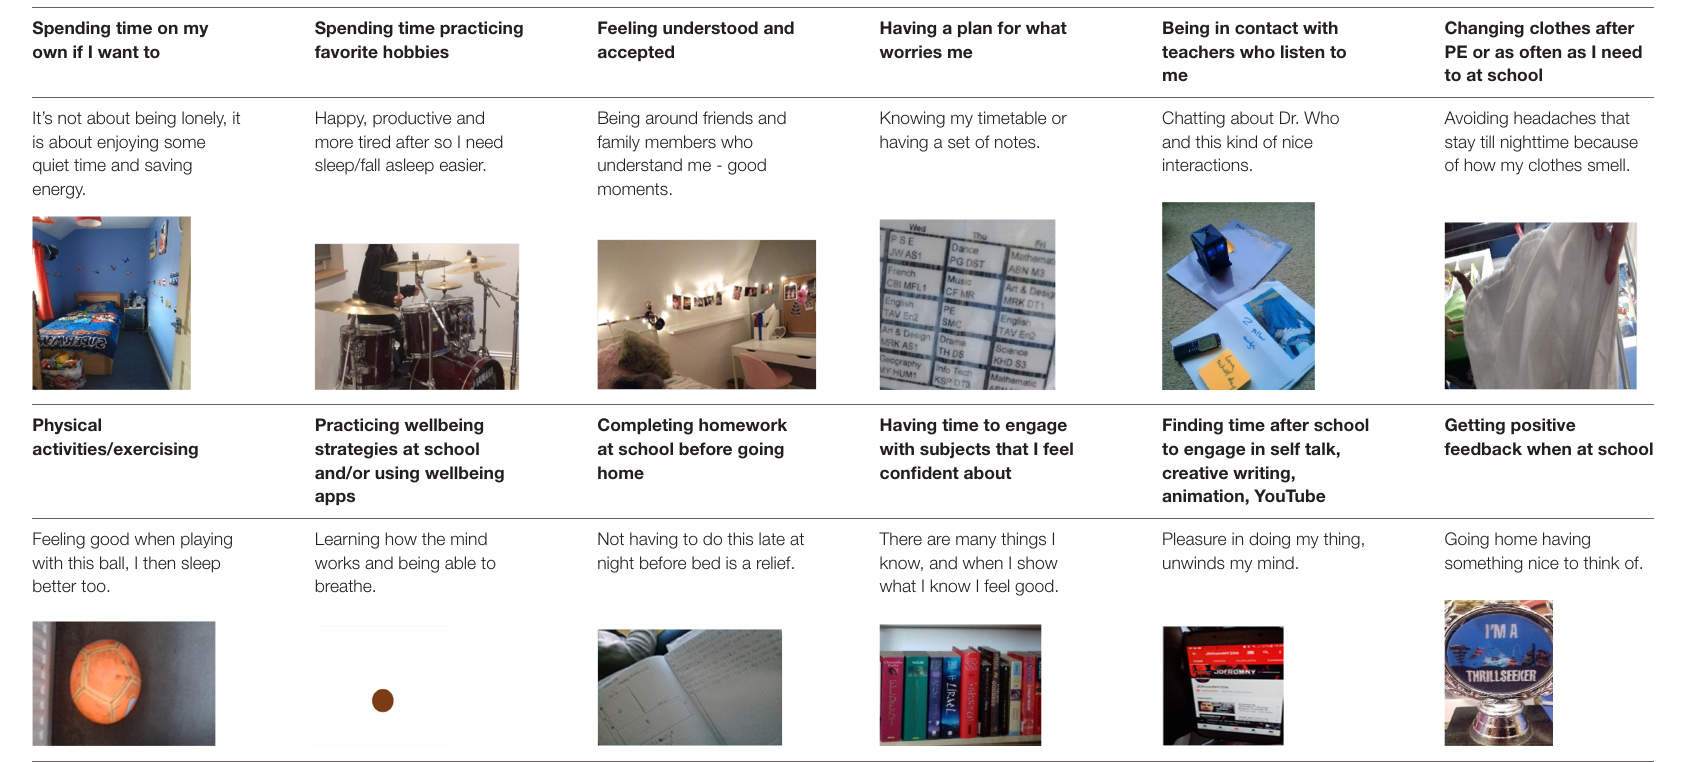
TABLE 6 | Daytime factors sample of codes, quotes, and photos. Spending time on my own if I want to